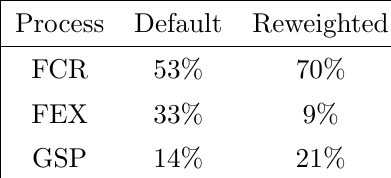
Table 3 . Contributions of the three production processes to selected dijets in pythia 6 before and after